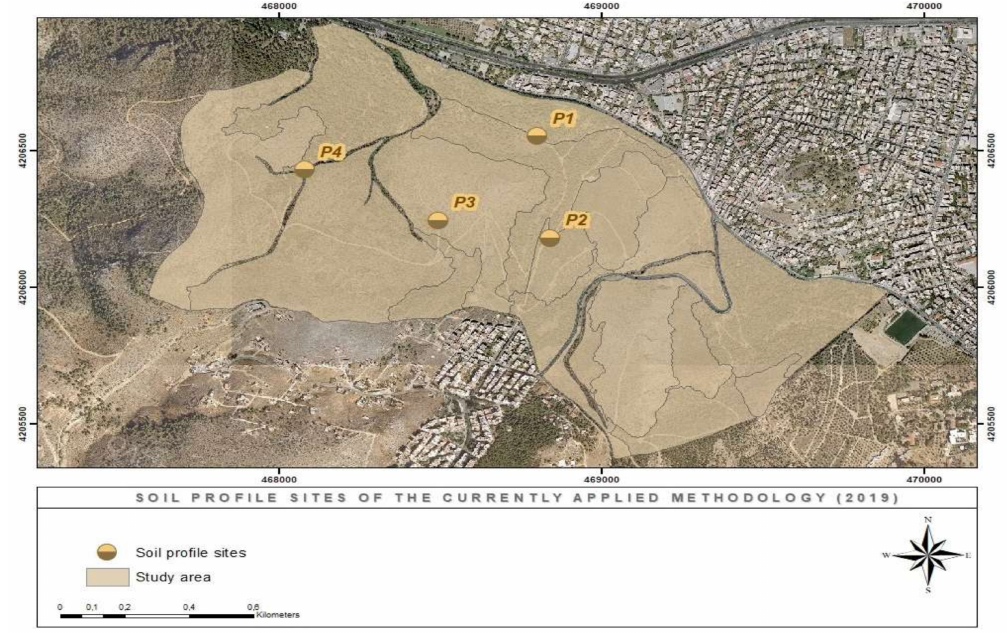
Figure 4. Profile sites of the new soil mapping